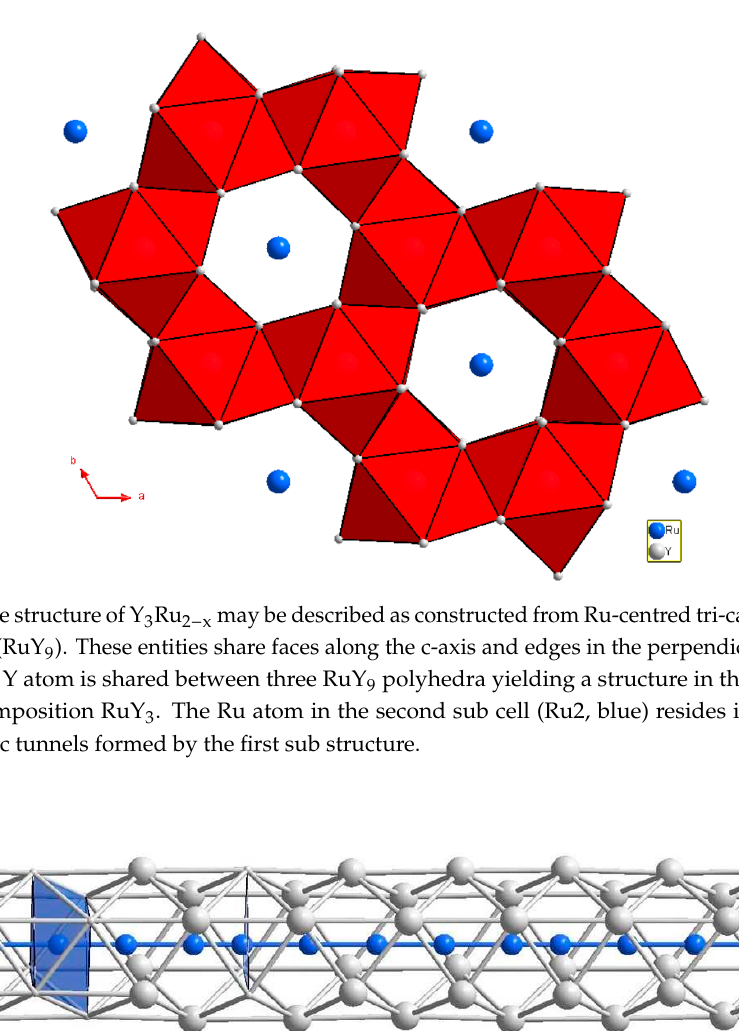
Figure 1. Reconstructed 0klm layer from the single crystal experiment. Sublattice reflections up to hk03 (yellow) and hk40 (red) are visible, as are mixed satellites (white). Diffuse scattering is visible for the hk01 layer and more prominent for the hk02 layer.